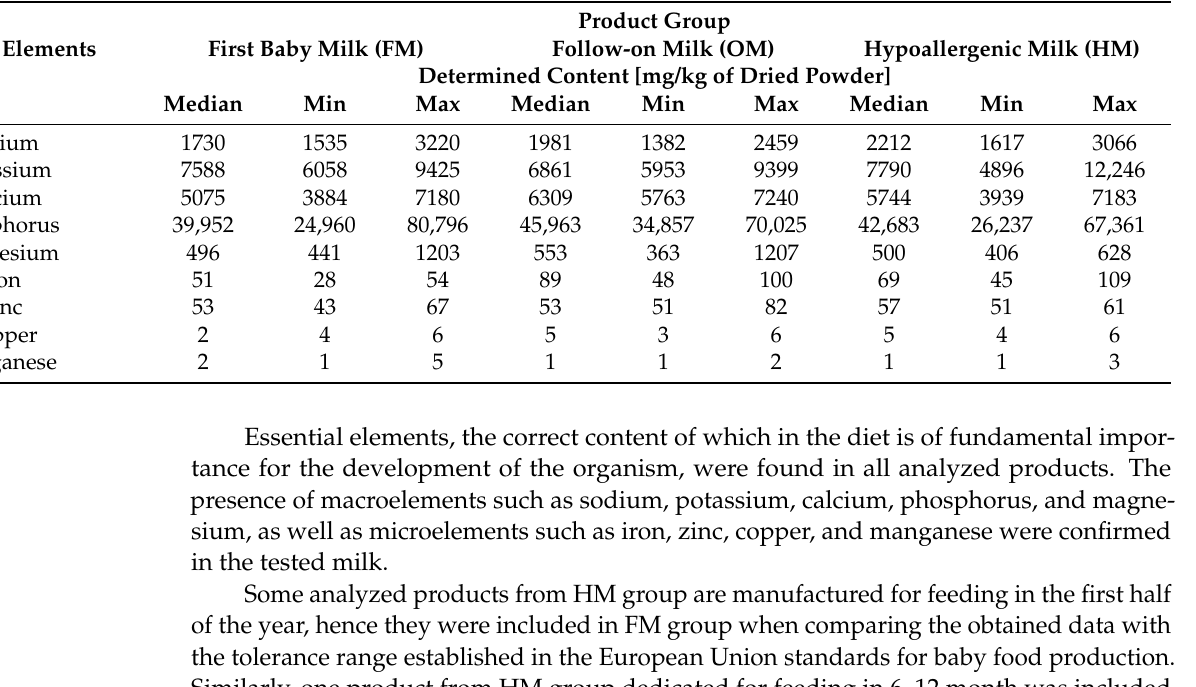
Table 1. The essential elements content in analyzed baby milks (mg/kg of dried powder).